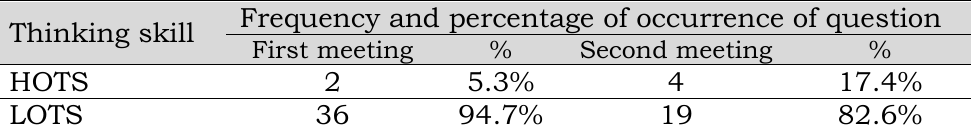
Table 2 : The Occurrence of Teacher